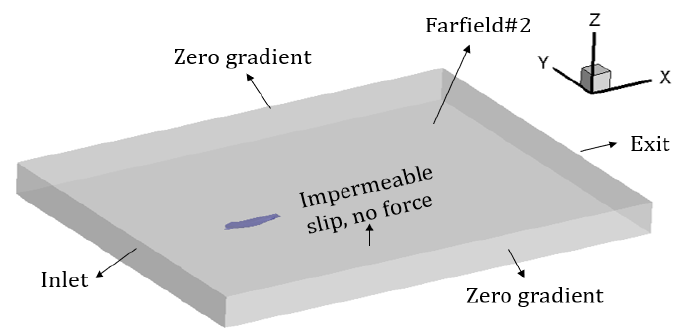
Figure 4. The computational domain for the model-scale calculations.